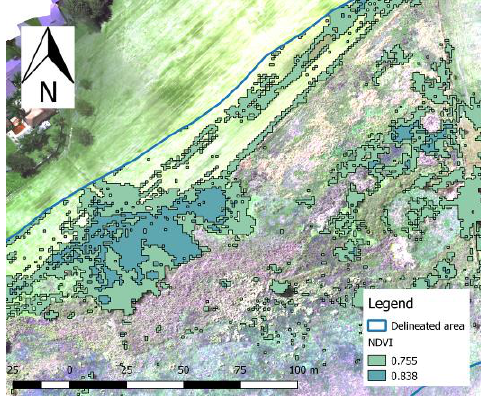
Figure 12. High NDVI values indicating dense stands of invasive grass (Kikuyu) including alien trees ( Acacia spp